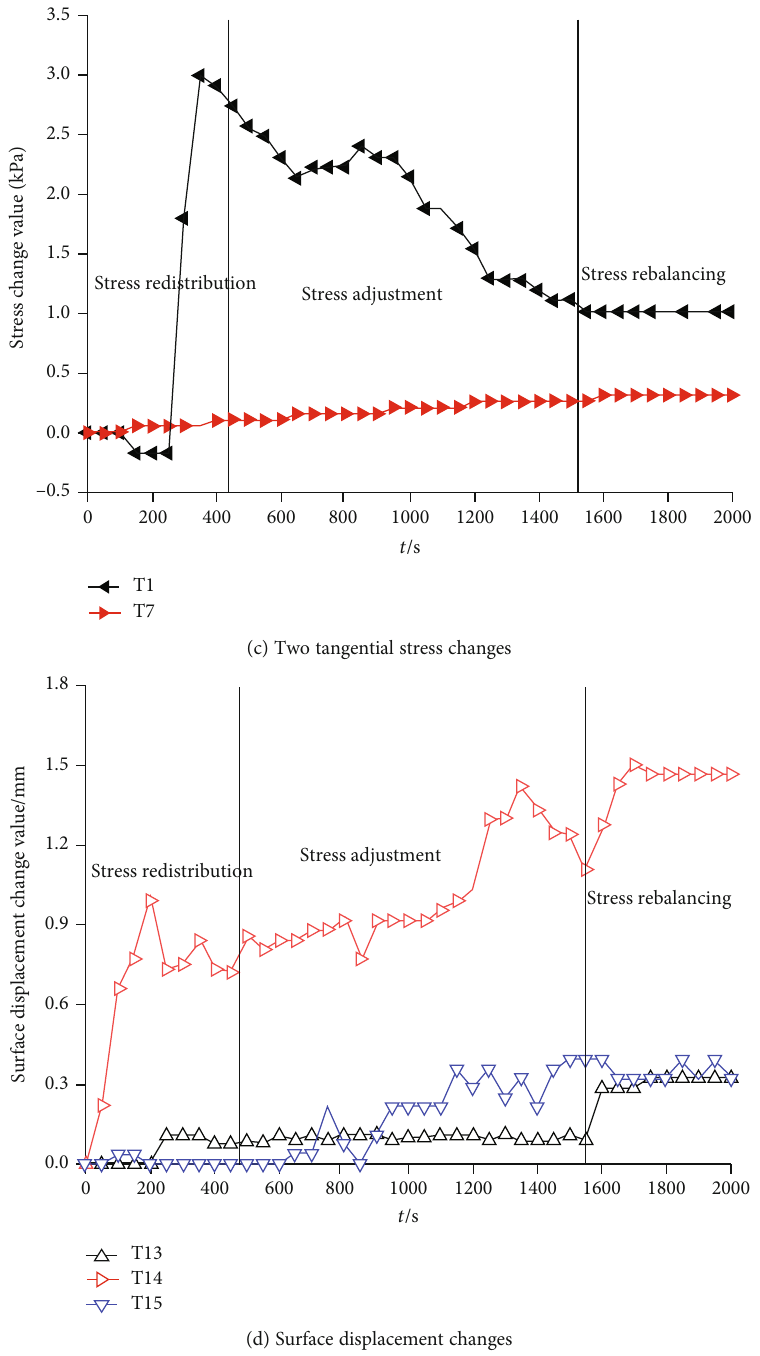
Figure 3: Variation of wall rock during the tunnel